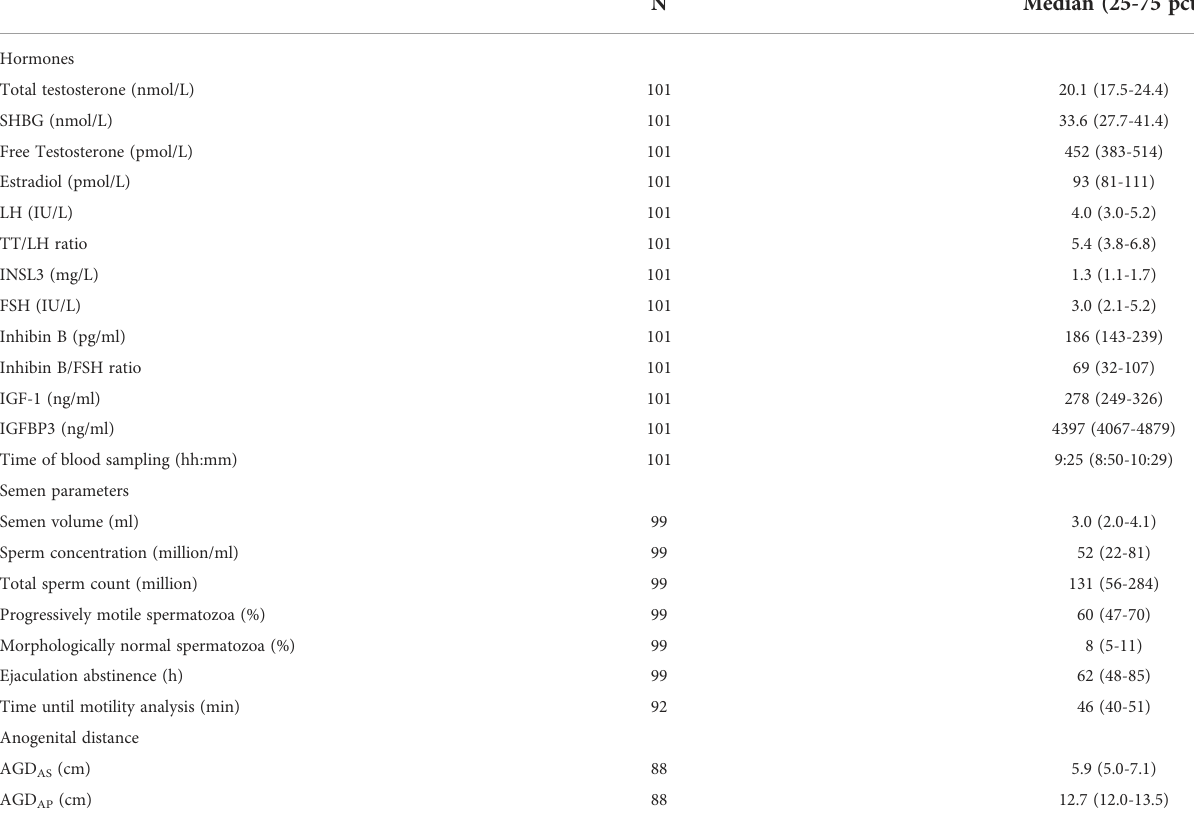
TABLE 3 Description of outcome variables for the study population with maternal chemical measurements and follow-up examination